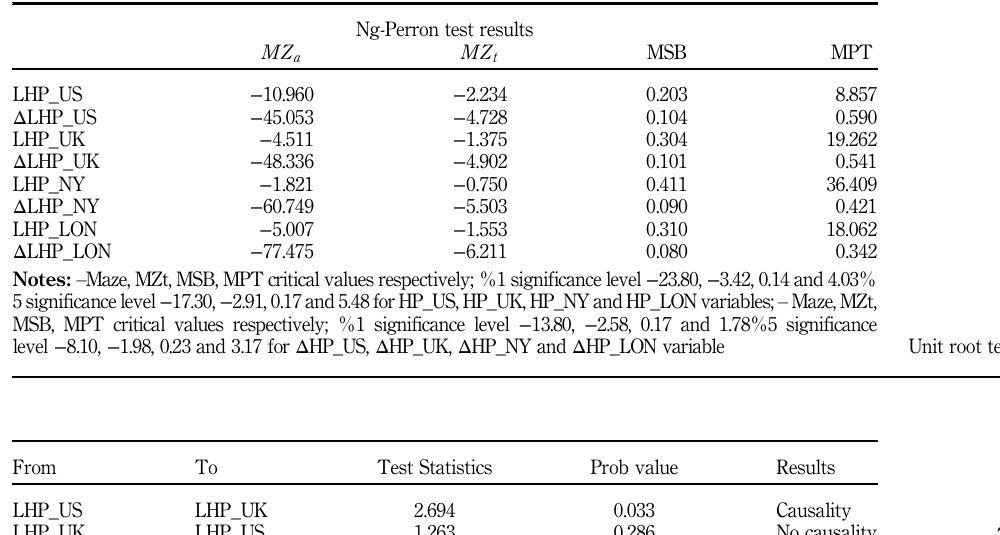
Table II. Toda and